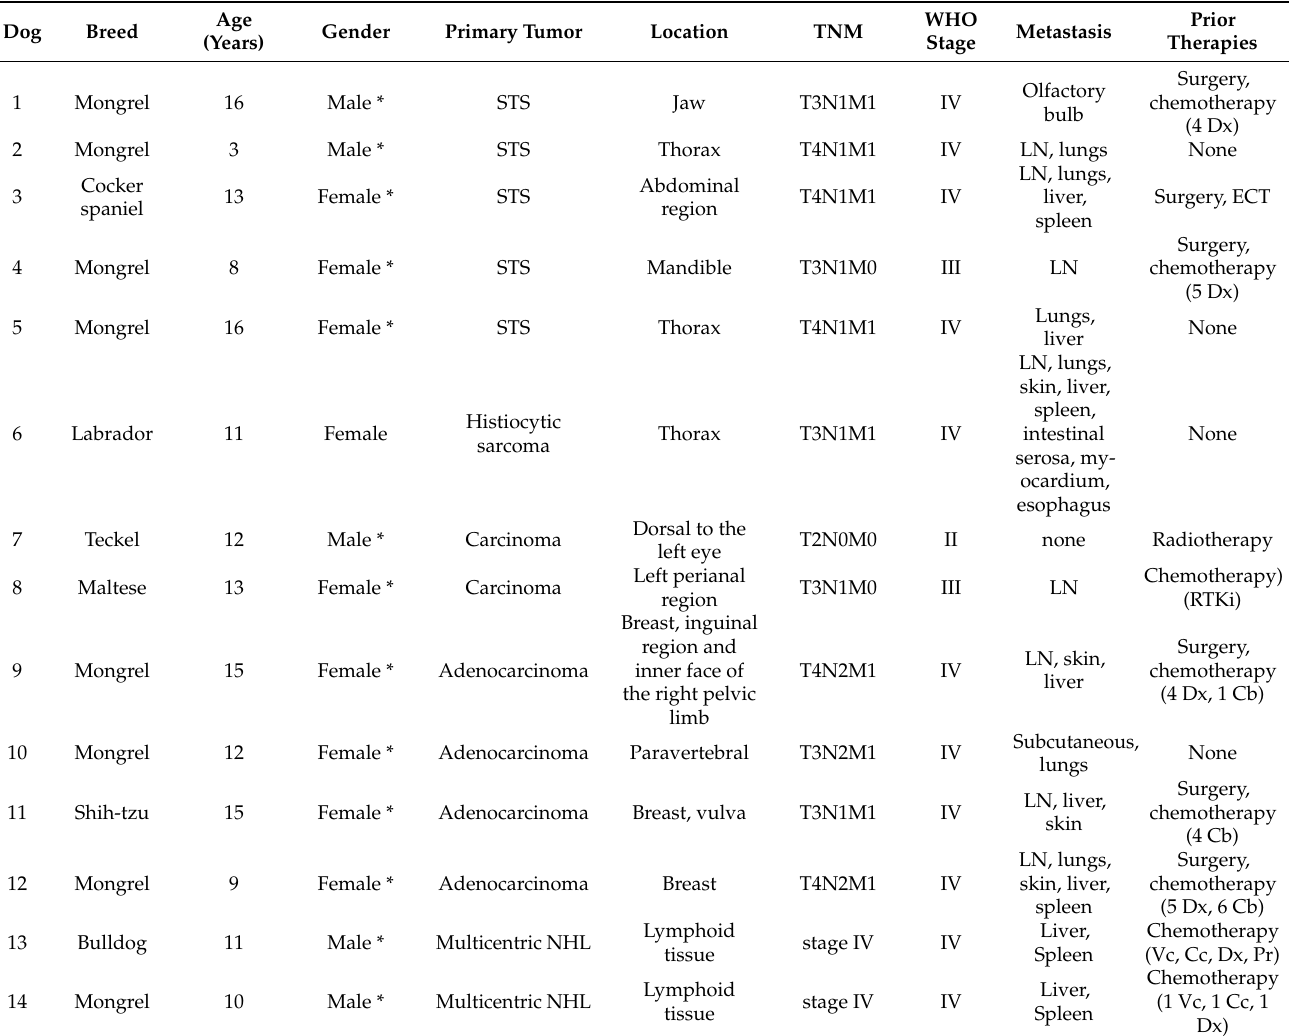
Table 1. Characteristics of the canine